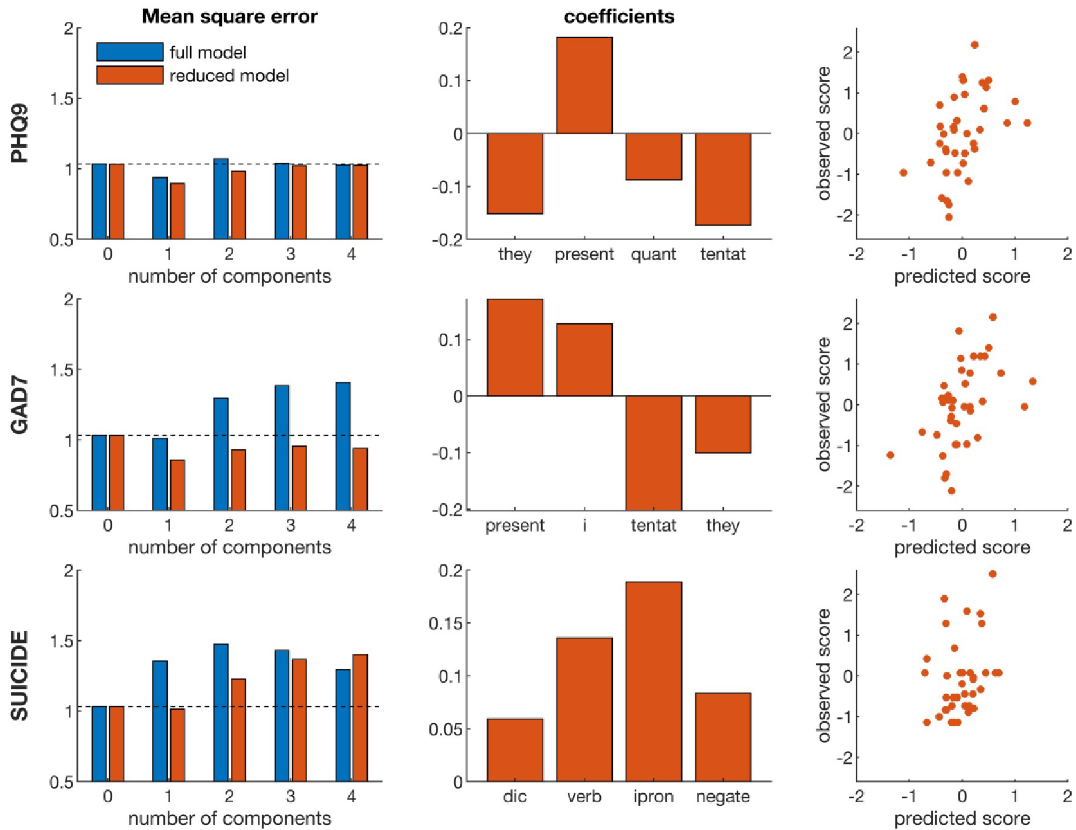
Fig 3. Results of PLS regression at group level. We used 5-fold cross-validation to determine the number of PLS components. The optimal model was the model showing the lowest MSE (left panel). We tested both the full model using all 68 linguistic features and a reduced model using only the 4 most robust features. The beta coefficients of the optimal model (middle column) were then used to estimate the predicted mental health scores (right column). Note: they = 3 rd person plural, present = present focus, quant = quantifiers, tentat = tentative, i = first person pronouns, dic = dictionary words, verb = auxiallary verbs, ipron = impersonal pronouns, and negate = negative